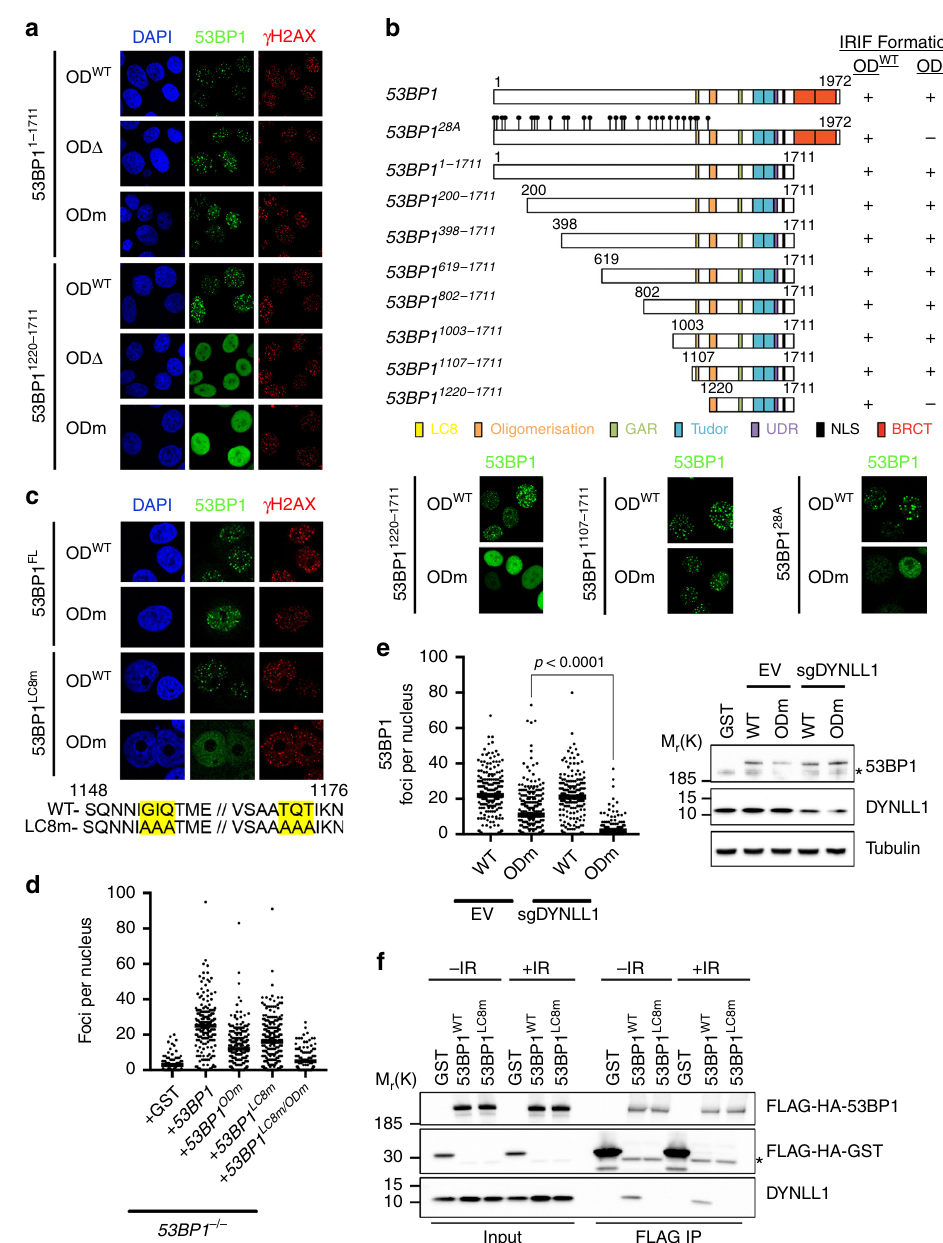
Fig. 1 DYNLL1 promotes OD-independent 53BP1 recruitment to DSB sites. a 53BP1 -/- MCF-7 cells stably expressing the indicated 53BP1 transgenes were irradiated (5 Gy), fi xed 4 h later, and immunostained with anti-HA (53BP1) and anti- γ H2AX antibodies. Data, representative of n = 3 independent experiments. OD Δ indicates deletion of amino acids 1230 – 1270 and ODm indicates mutation of amino acids 1258 – 1261 to alanine. b IRIF forming capability of indicated 53BP1 constructs was determined in stable cell lines as in ( a ) 4 h following 5 Gy irradiation in a minimum of n = 2 independent experiments. c As in ( a - b ), but with indicated WT and mutant 53BP1 constructs. Data, representative of n = 2 independent experiments. Amino acids 1142 – 1181 of